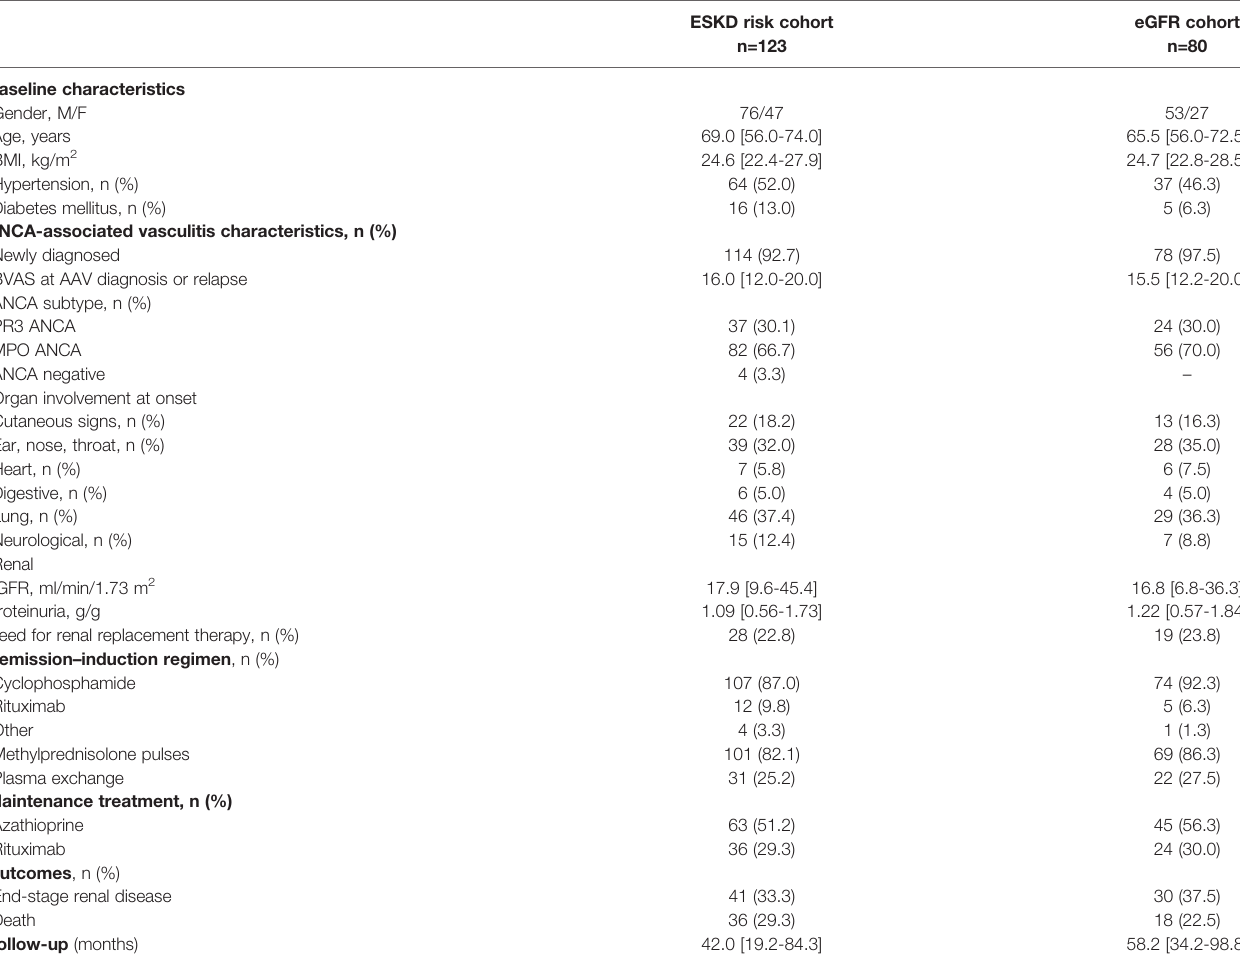
TABLE 1 | Baseline characteristics of the population and main